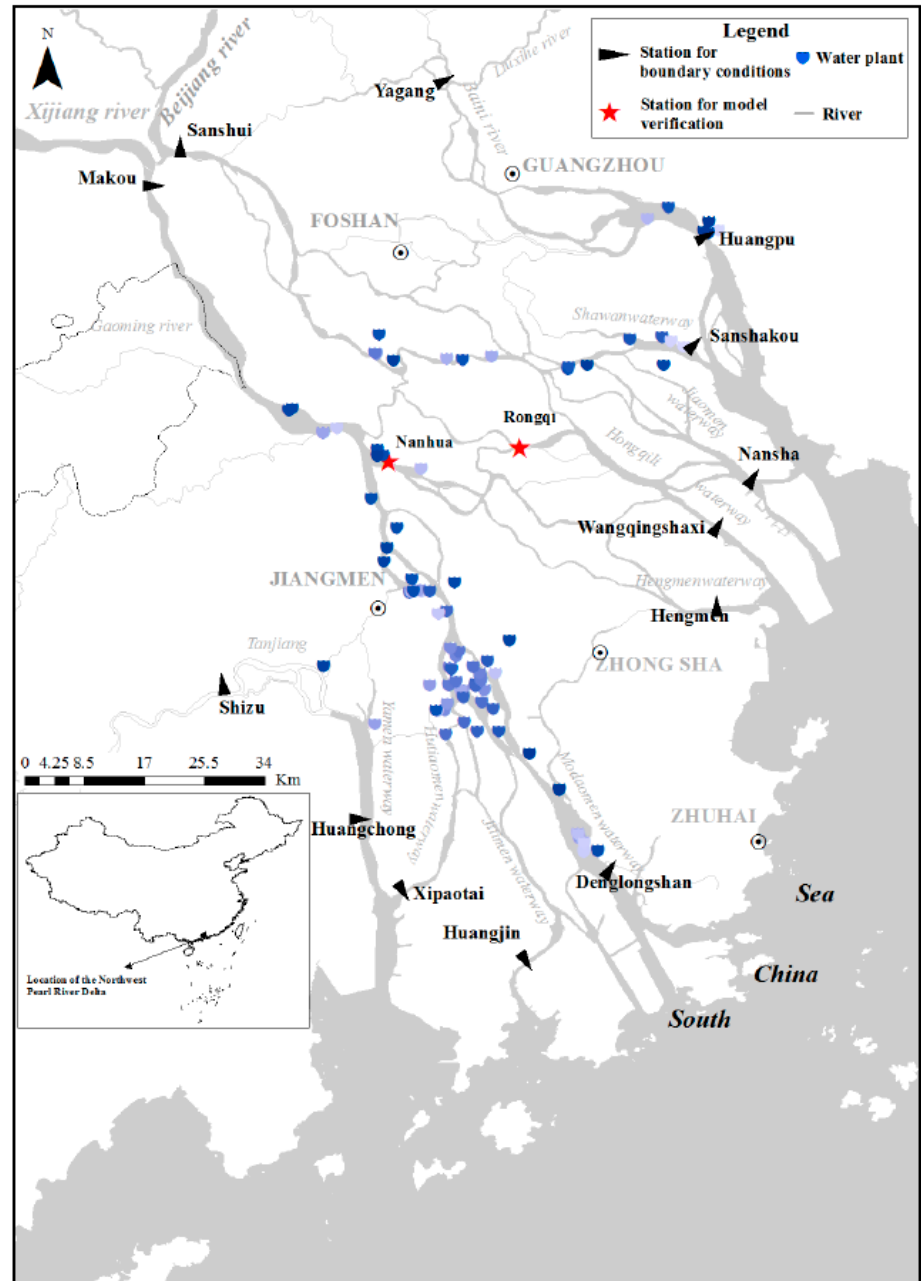
Figure 2. Location of the Northwest Pearl River Delta (The shade of indicates the size of water plant, the deeper blue, and its bigger size).